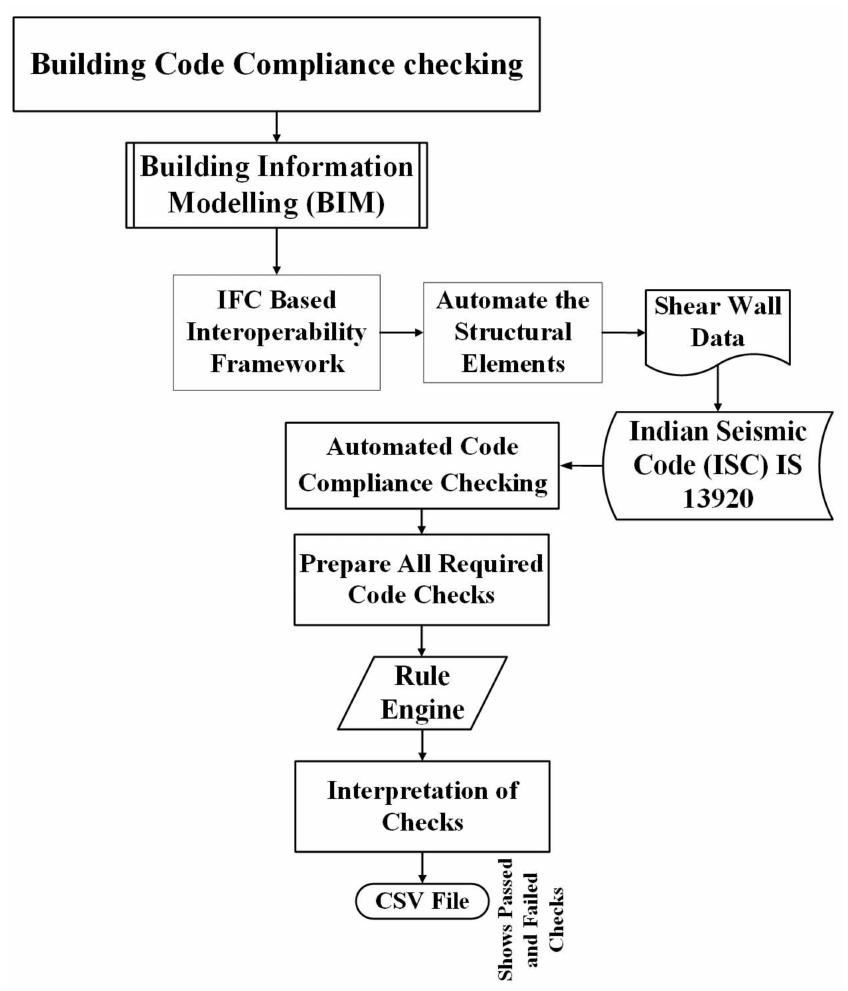
Figure 1. Flow diagram of the